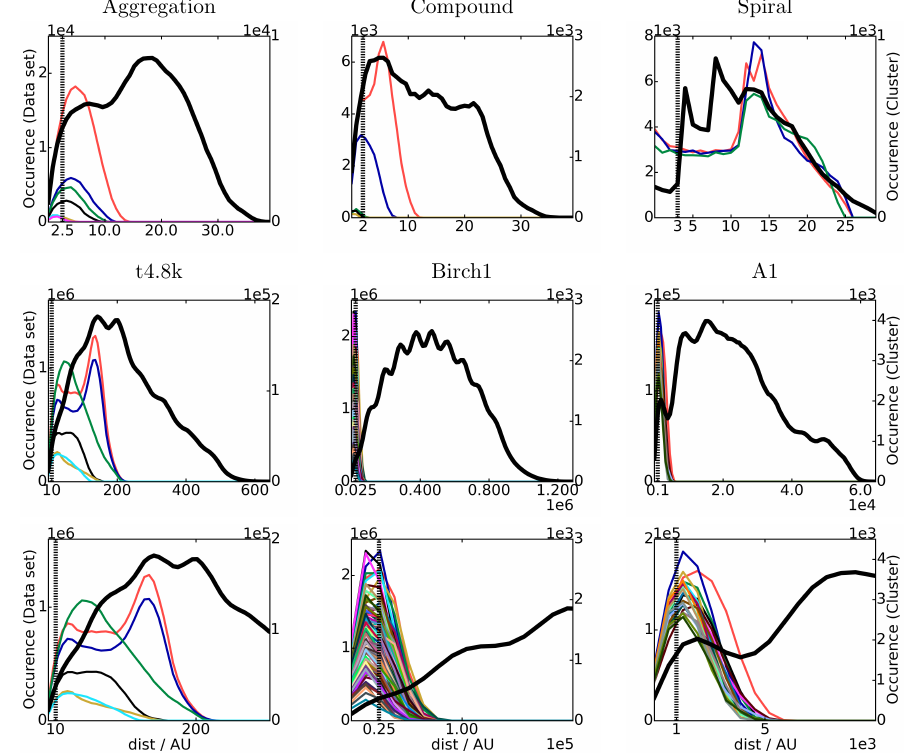
Figure 5. Distance distribution of different datasets (left axis, black). Distance distribution of the isolated clusters (right axis, colored according to the clusters in Figure 2). In the third row, a zoom into the datasets of the second row is shown. The dashed line denotes the chosen cutoff distance R for each